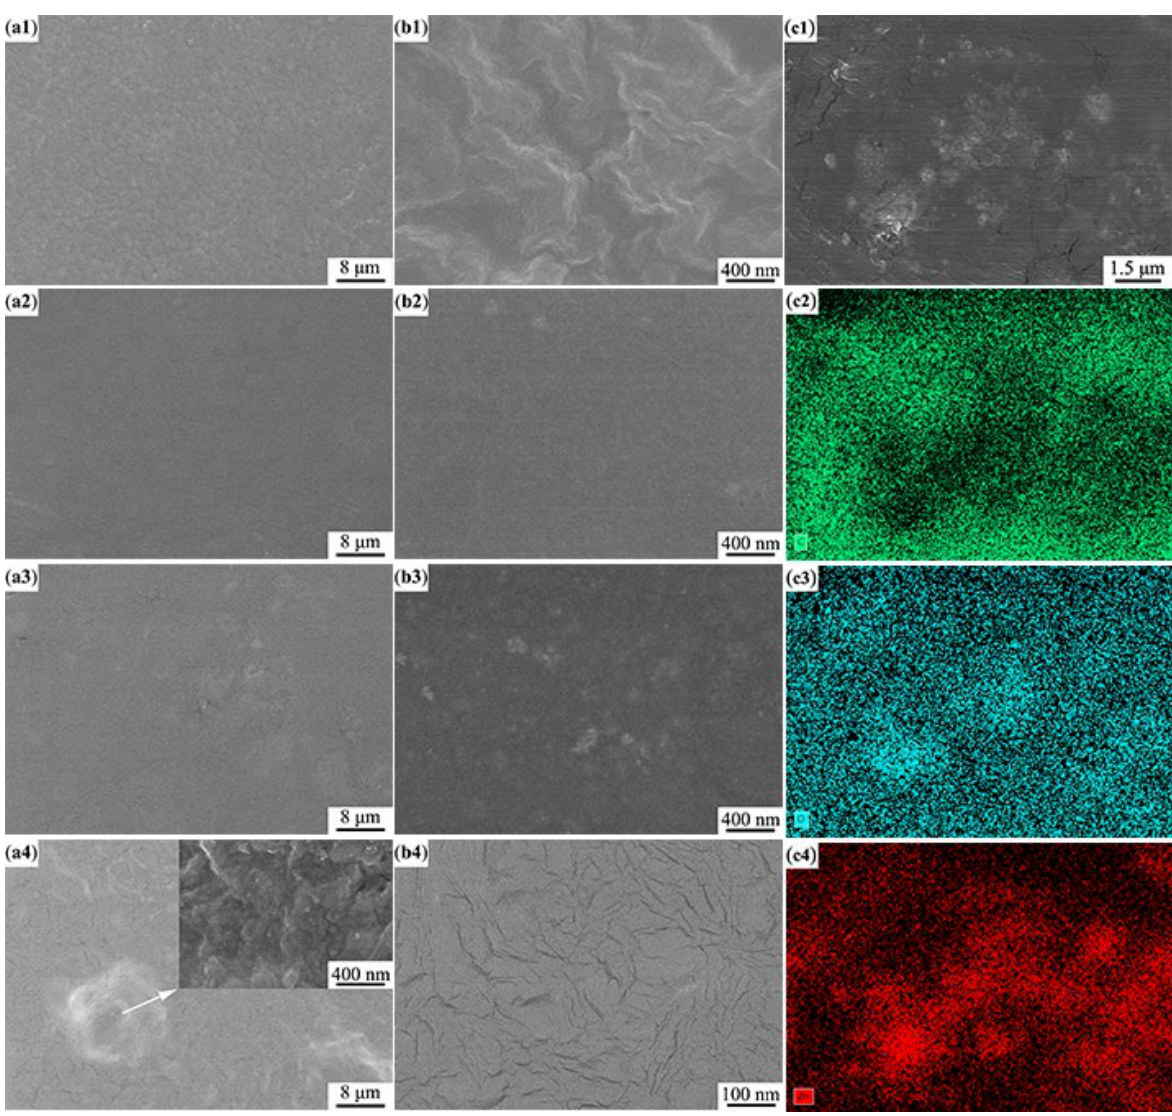
Figure 2. SEM images of the SPEs: ( a1,b1 ) 0 wt.% ZnO [26], ( a2 , b2 ) 1 wt.% ZnO, ( a3 , b3 ) 3 wt.% ZnO, and ( a4 , b4 ) 5 wt.% ZnO, and the SEM image and the corresponding energy dispersive spectroscopy mapping images of the SPE with 5 wt.% ZnO: ( c1 ) SEM image, mapping images of ( c2 ) C, ( c3 ) O, and ( c4 ) Zn.